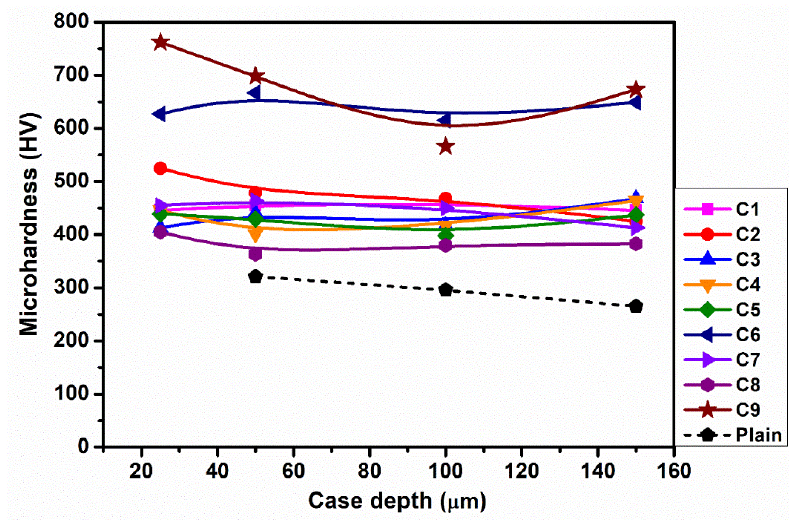
Figure 8. Microhardness profile of transverse sections of impregnated and plain EN 31 specimen C type pins, i.e., at 960 °C.